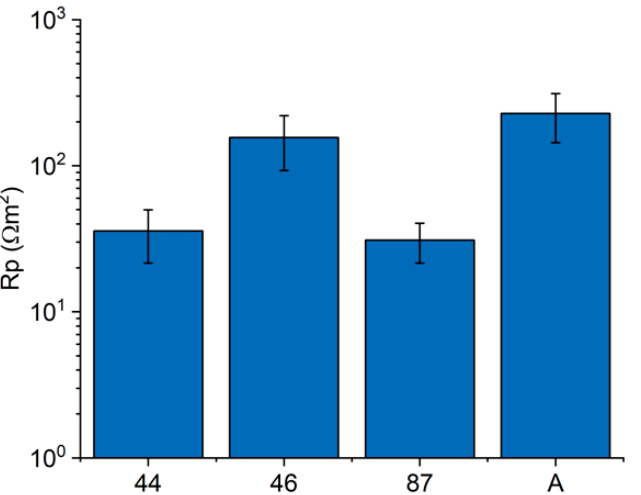
Figure 11. Nyquist plots of Sample 44 ( a ) and Sample A ( b ).